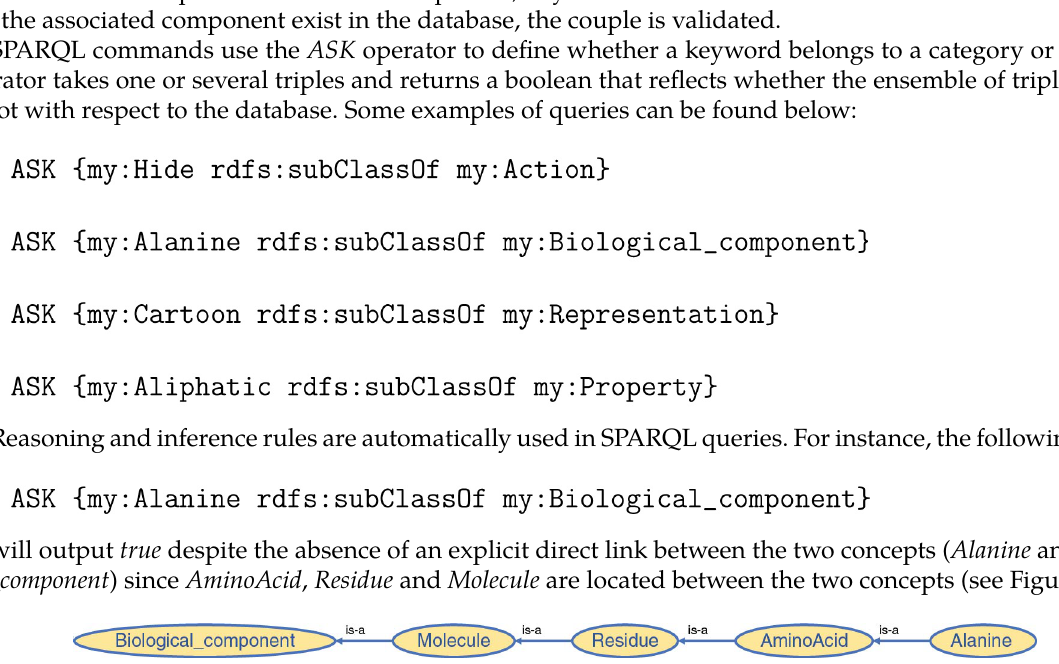
Figure 4: Extract from our OWL ontology for the Alanine concept